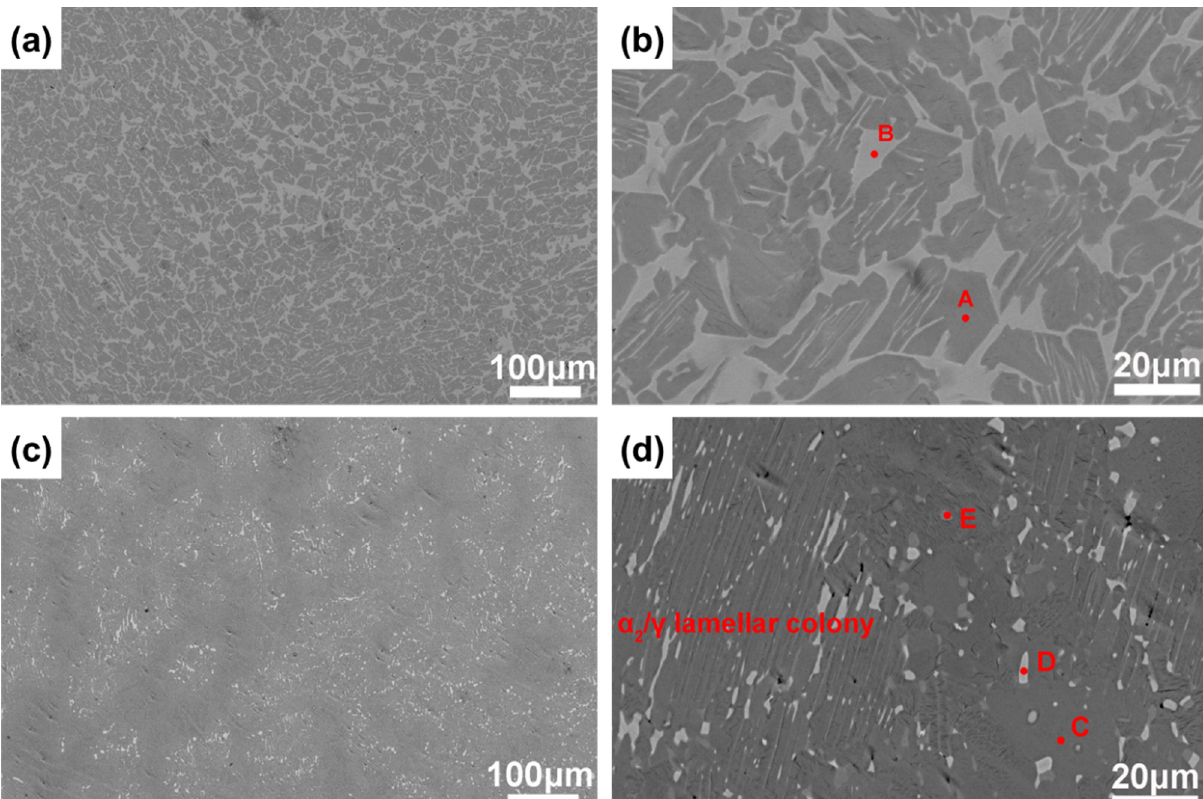
Figure 4. The SEM-BSE photos of as-forged TiAlMn and TNM alloys: ( a , b ) TiAlMn alloy, ( c , d ) TNM alloy.